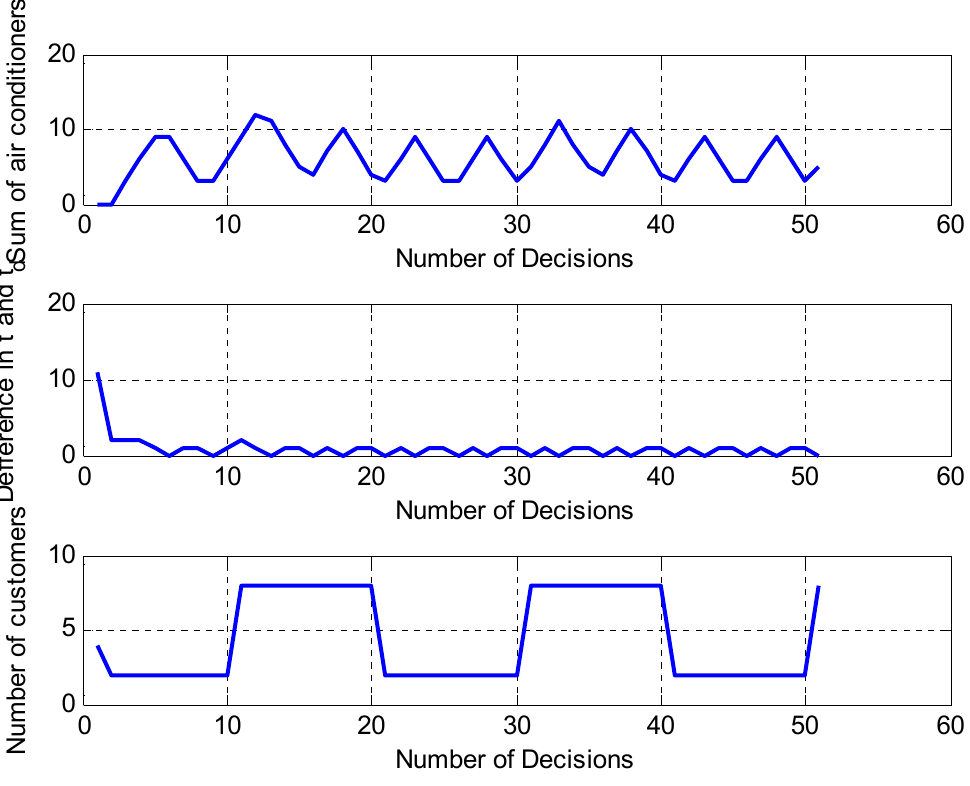
Figure 7. Variation in number of customers.